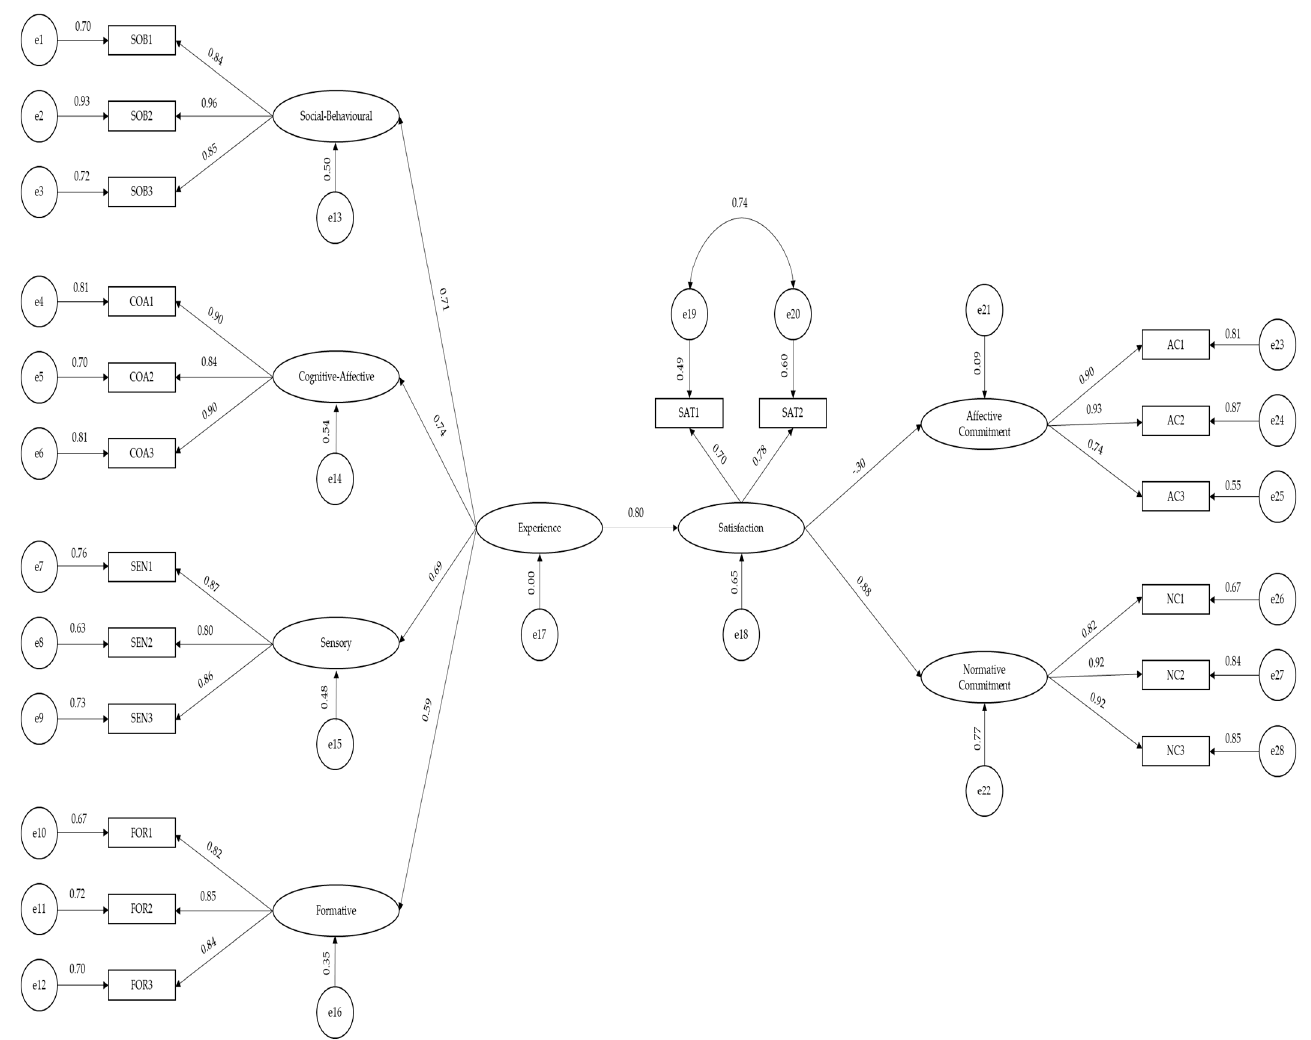
Figure 3. Estimation of model.